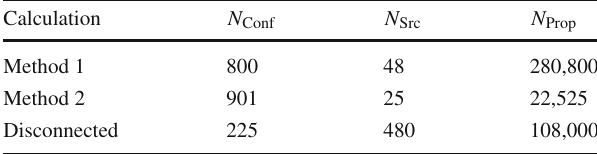
Table 7 Resources used for the calculations on ensemble N202. N Conf gives the number of gauge configurations used, N Src the number of source positions per gauge configuration, and N Prop the total number of propagator solves